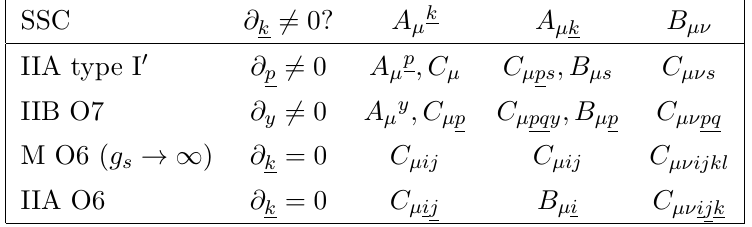
Table 8 . Field components in the expansion: A µk for ∂ k identities. For the O8 case and O7 case, this means the RR field components in A µk . Notation as in table